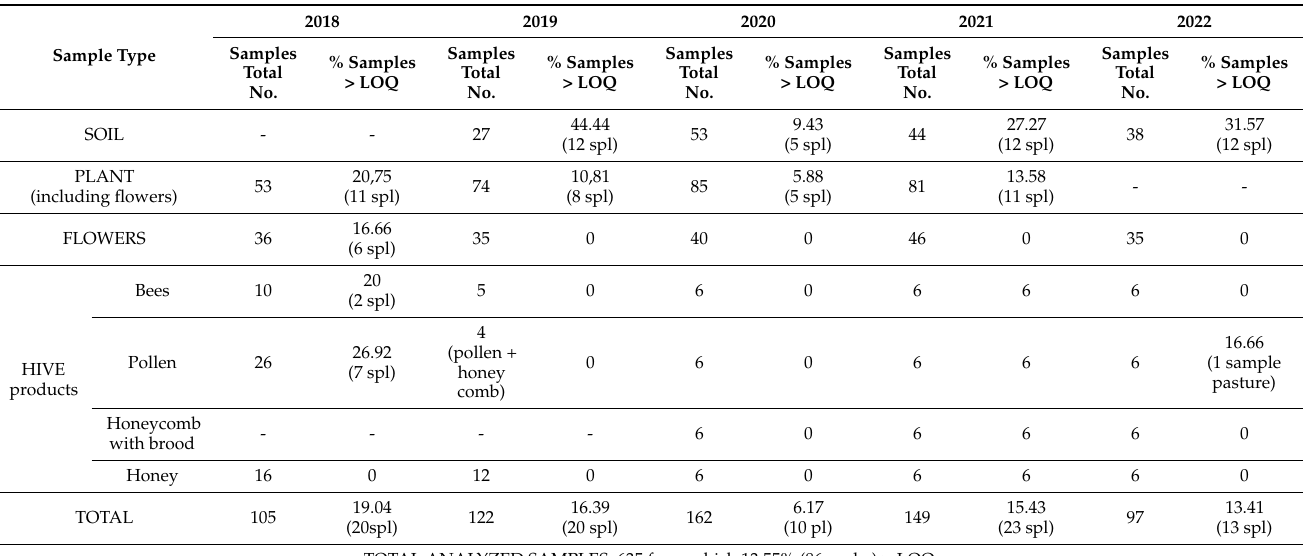
Table 4. Summary of the results regarding the level of residues of imidacloprid, clothianidin and thiamethoxam during the 5 years of